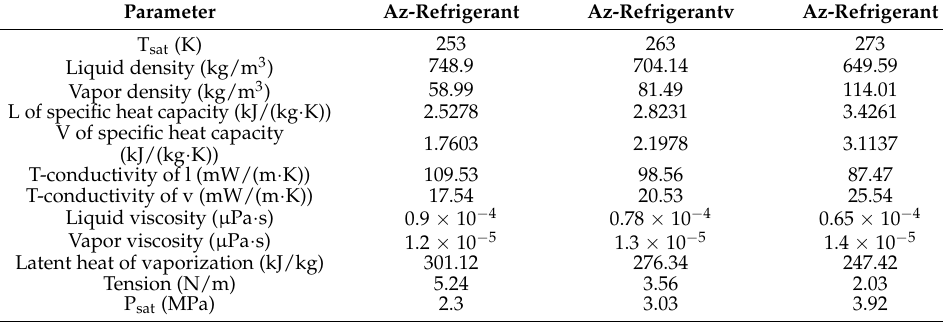
Table 3. Thermophysical parameters of the azeotropic